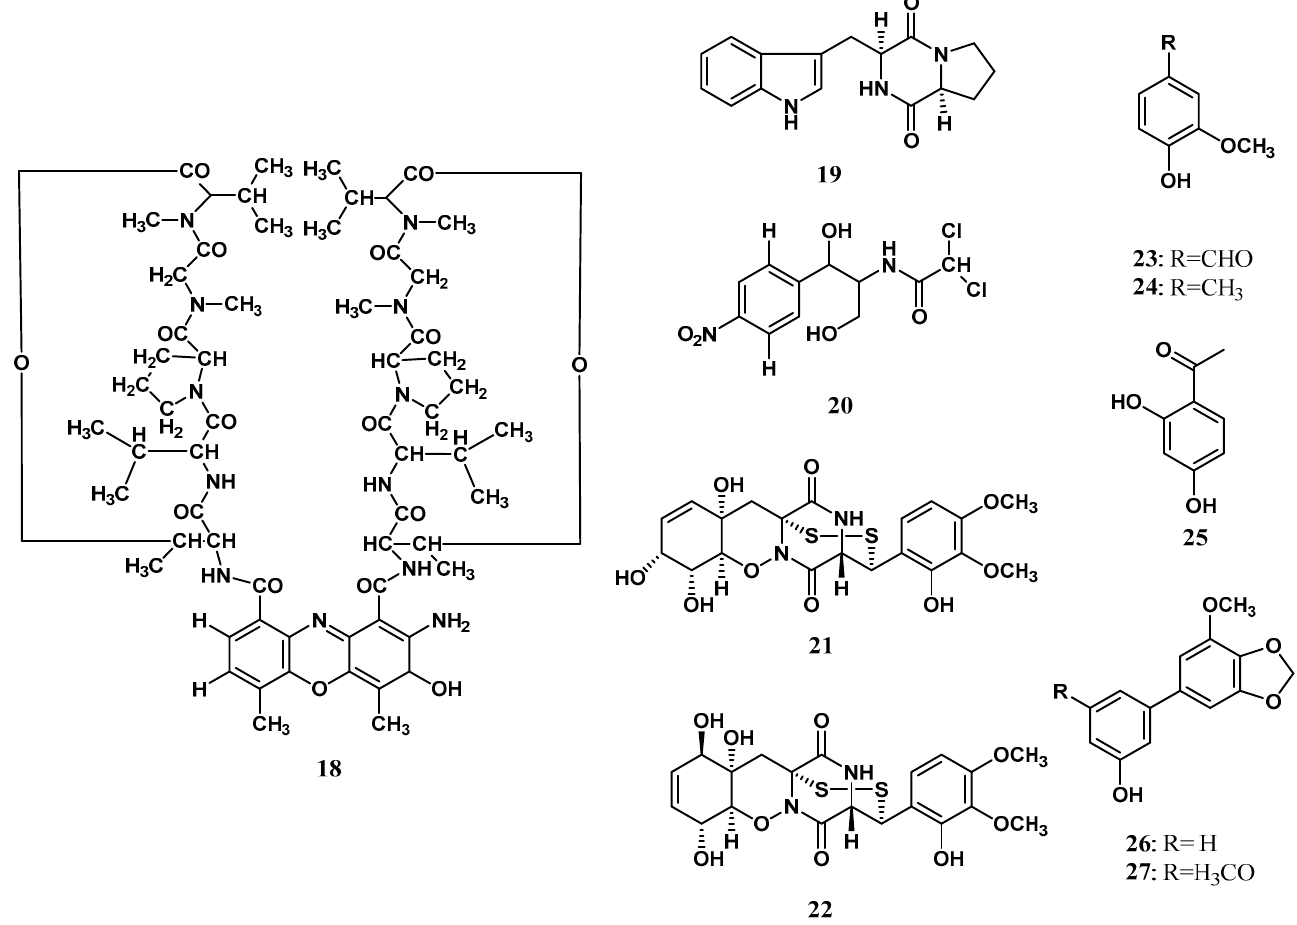
Figure 2. Nonribosomal peptides and aromatic compounds from Zingiberaceae endophytes.